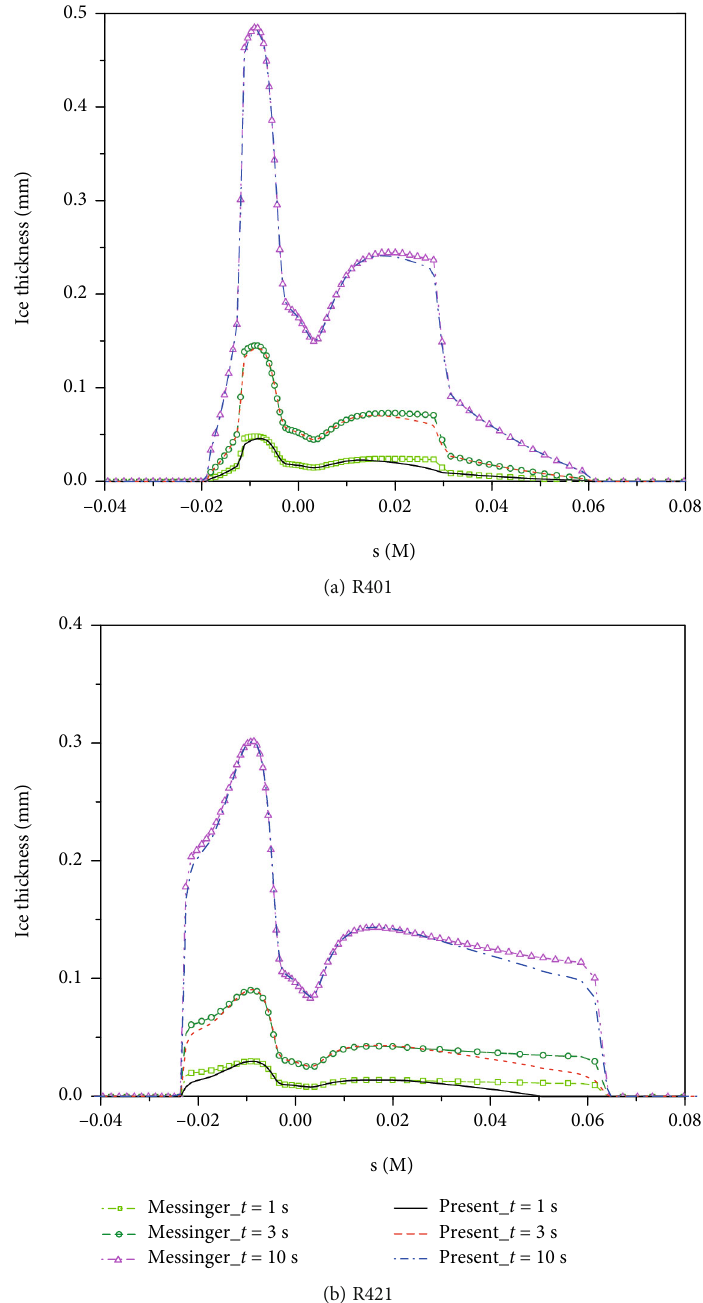
Figure 8: Growth processes of the ice